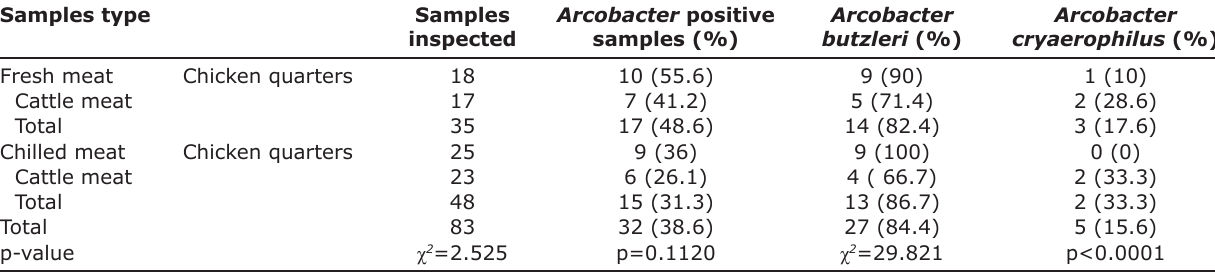
Table-2: Prevalence of Arcobacter spp. in retail meat traded in Wasit marketplaces. Samples